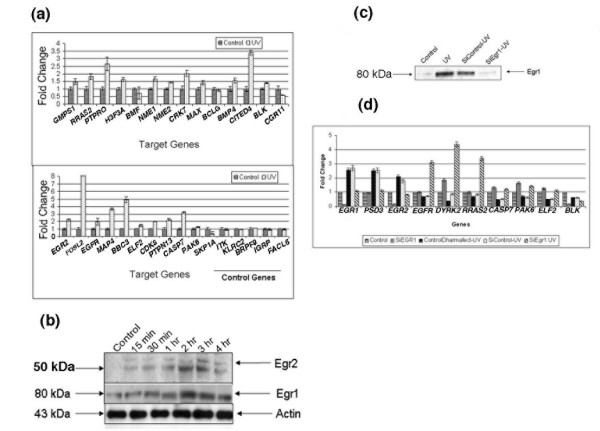
Validation of ChIP-on-chip results. (a) ChIP products for M12 cells treated with UV-C or untreated controls (control) were analyzed by qRT-PCR. The data are expressed as relative fold change of real-time PCR results to untreated control ChIP sample. The experiments were performed in triplicates and the error bars represent the triplicate data. (b) Western blot analysis of Egr2 (an Egr1 target gene) to define time of maximum induction. (c) M12 cells were treated with siRNA against Egr1 (SiEgr1) or SiGenome control (SiControl) for 48 h followed by UV-C irradiation and western blot confirmed the suppression of Egr1 in SiEgr1 treated cells. (d) qRT-PCR analysis of Egr1 target genes using RNA extracted from SiEgr1- or SiGenome control-treated M12 cells with or without UV-C irradiation. All the results are expressed relative to GAPDH.